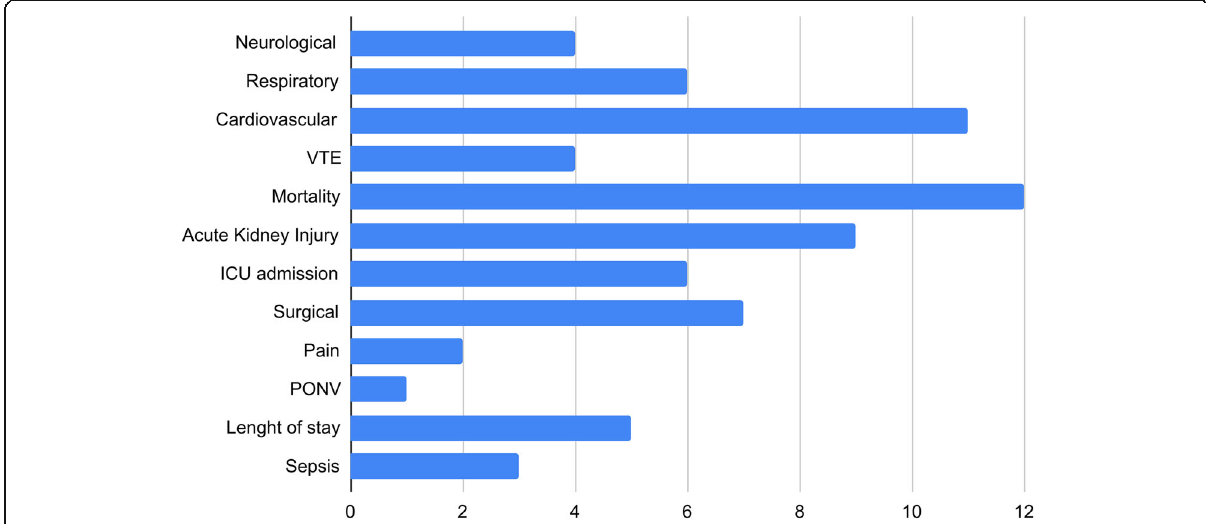
Fig. 4 Main outcomes (preoperative/intraoperative) considered in our